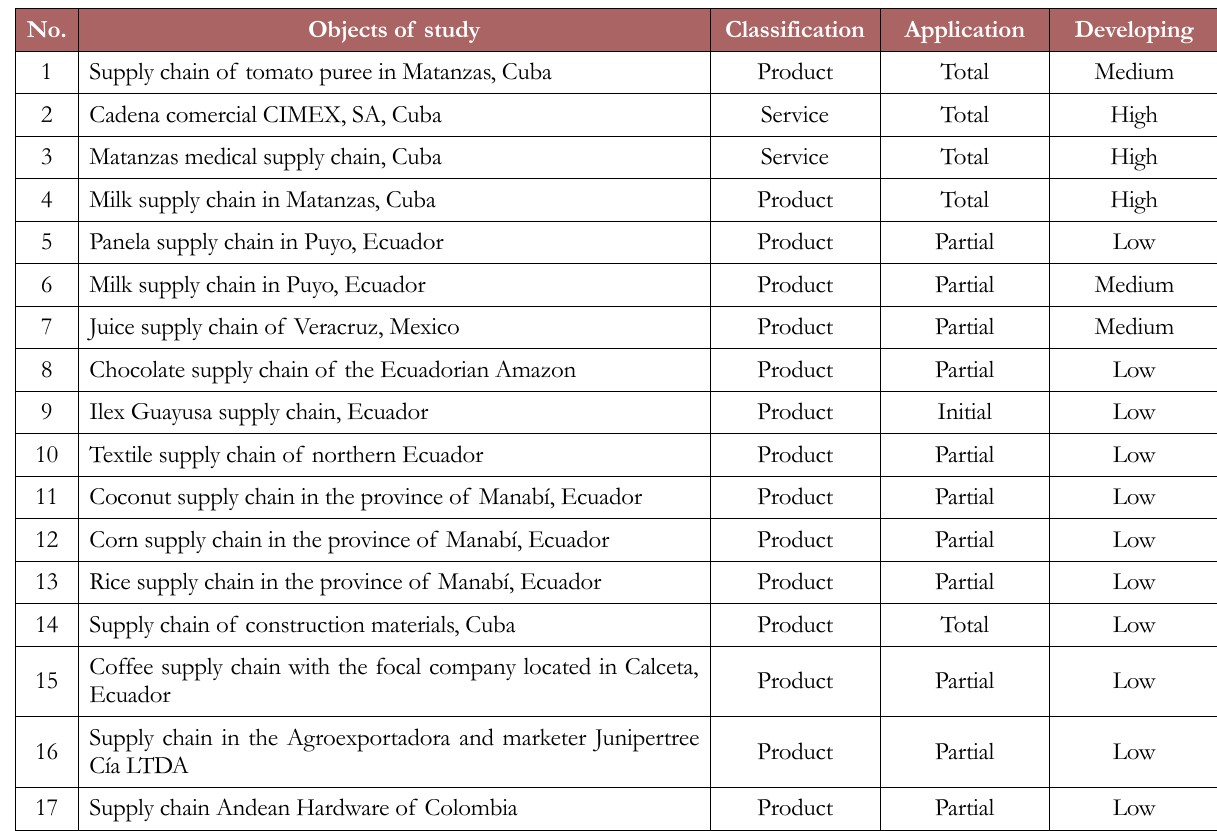
Table 1. Studies of supply chains of various countries, products and scopes (Elaborated from the results and research articles of Sablón and collaborators from 2013 to